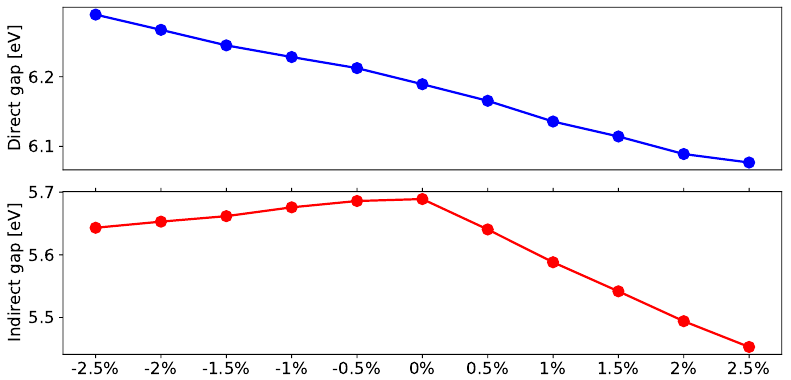
Figure 3: [ Color online ] Quasi-particle corrections to the direct and indirect gaps with respect to